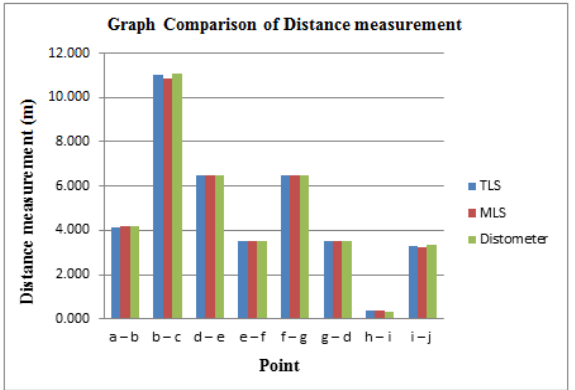
Figure 11: Graph comparison of distance